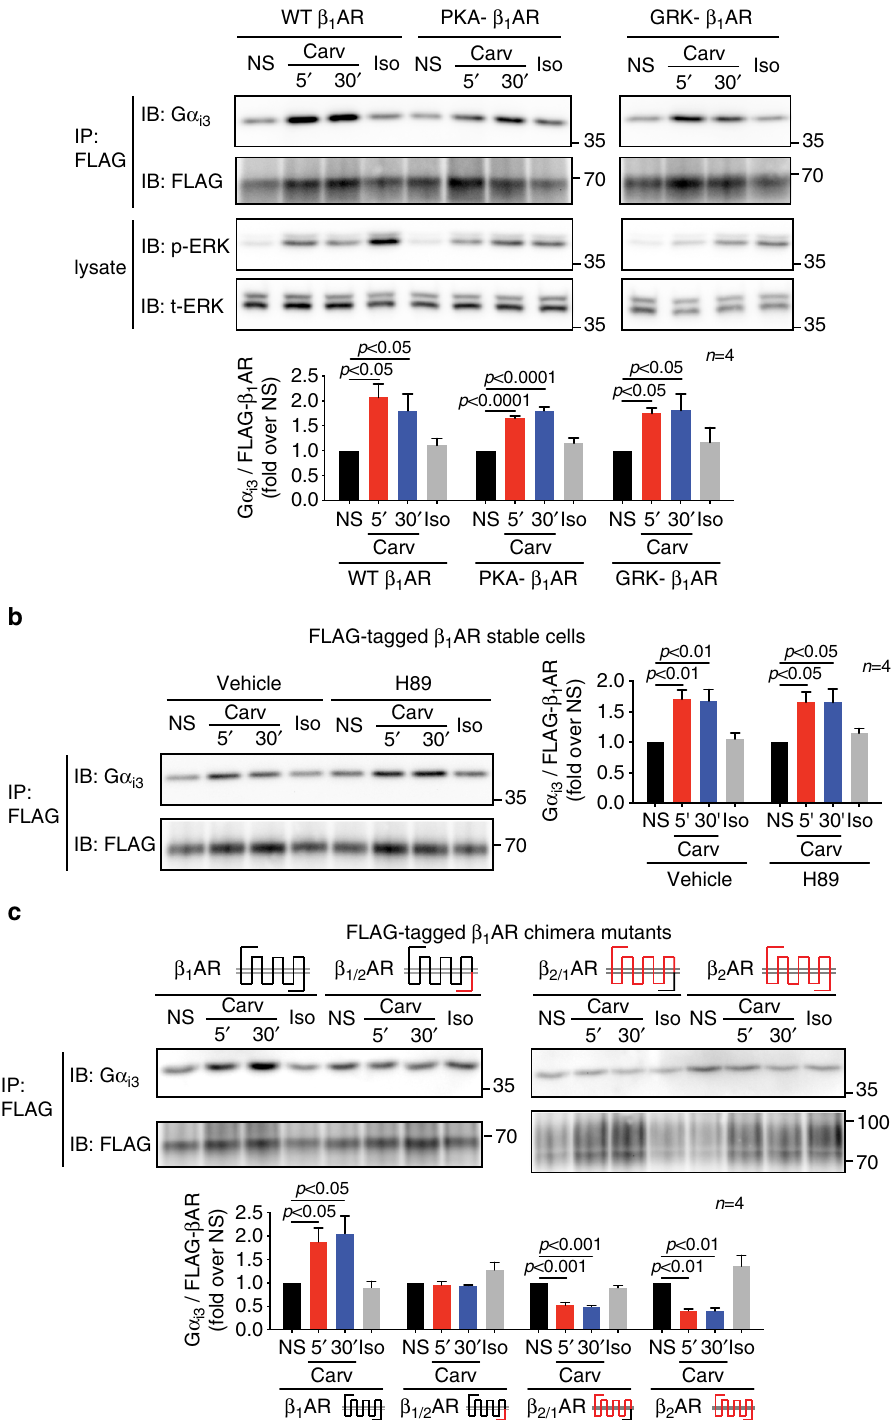
Fig. 8 Neither PKA-mediated nor GRK-mediated β 1 AR phosphorylation is required for carvedilol-induced G α i recruitment. C-tail of β 1 AR is required but not suf fi cient for G α i recruitment. a HEK293 cells were transfected with FLAG-tagged wild-type, PKA- or GRK- β 1 ARs. Carvedilol promoted G α i recruitment to mutant β 1 ARs lacking the putative PKA- or GRK-mediated phosphorylation sites, to a similar extent as to the wild-type β 1 ARs. b HEK293 cells stably expressing FLAG-tagged β 1 ARs were pretreated with vehicle or 10 μ M H89 for 30 min. The PKA inhibitor H89 did not have a signi fi cant effect on carvedilol-induced β 1 AR – G α i coupling. c HEK293 cells were transfected with FLAG-tagged β 1 AR, β 2 AR or chimeric β AR constructs in which the receptor C-tails were exchanged between the two receptor subtypes. Carvedilol did not promote G α i recruitment to the β 1 AR with C-tail from β 2 AR. On the other hand, the β 1 AR C-tail did not make β 2 AR capable of recruiting G α i with carvedilol stimulation. Data represent the mean ± SEM for n independent experiments as marked on the fi gure. Statistical signi fi cance vs. unstimulated cells was assessed using one-way ANOVA with Bonferroni